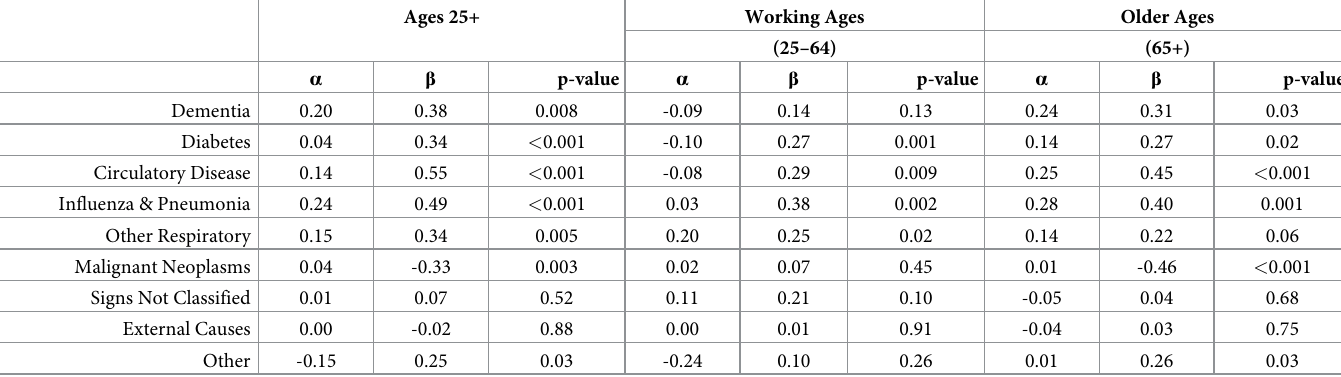
Table 4. Regression of state-level change in cause-specific mortality on COVID-19 mortality, standardized coefficients.